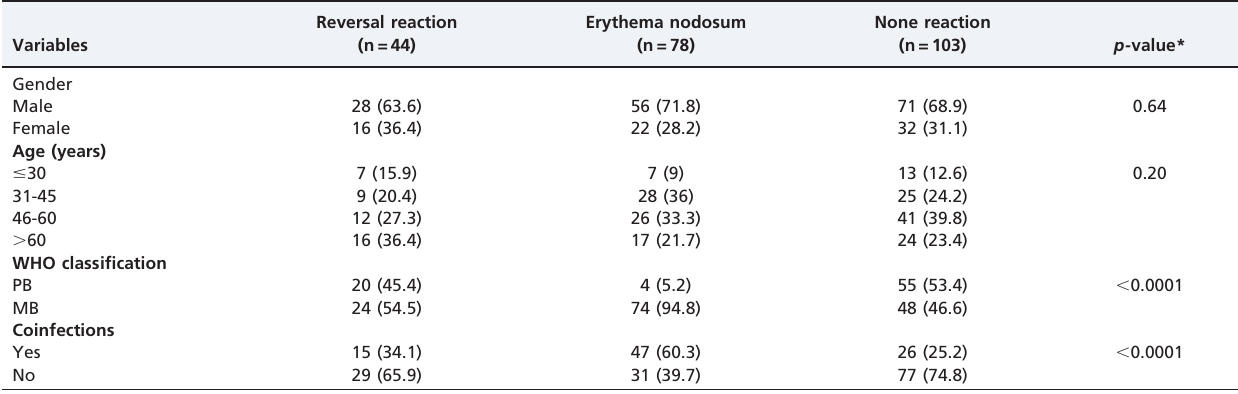
Table 2 - A comparison of the number (n) and percentages (%) of reactional episodes (RE) by gender, age and the presence of infections among the leprosy patients managed at the Leprosy Clinics of the Ribeira˜o Preto Clinical Hospital in the Medical School of Sa˜o Paulo University, calendar period 2000-2010.